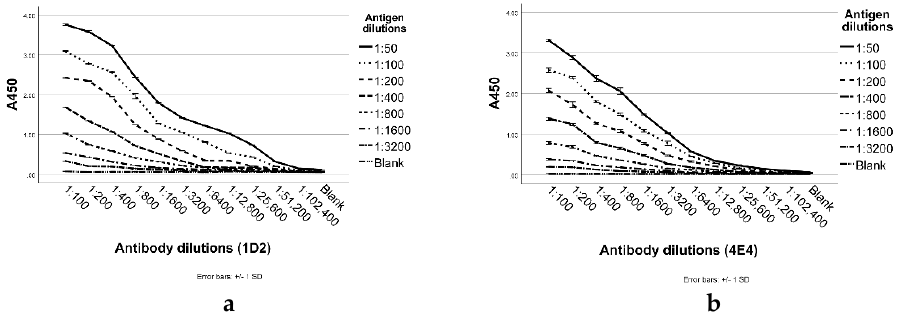
Figure 1. Purified 1D2 and 4E4 detect immobilized Aspergillus fumigatus cell wall fragments by ELISA. A range of concentrations (0.0275 ‐ 1.76 μ g/mL) of A. fumigatus cell wall antigens were coated on the microtiter plate. After blocking and washing, the immobilized fragments were detected by adding purified 1D2 ( a ) or 4E4 ( b ) with serial dilutions (0.0098 ‐ 10 μ g/mL) and goat anti ‐ mouse IgM ‐ HRP (1:2000). A450: Absorbance at 450 nm.